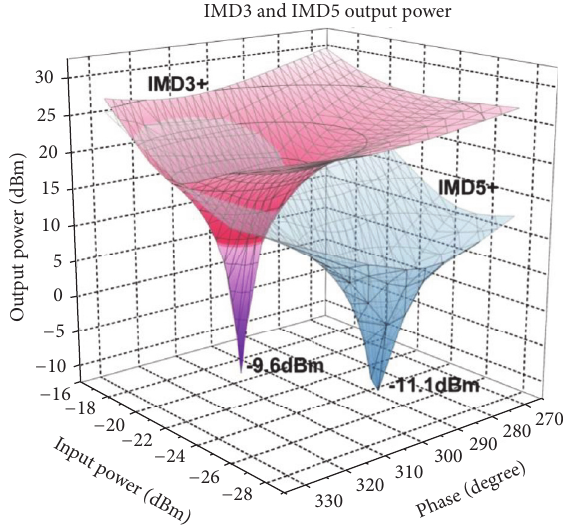
Figure 4: The 3D plot of the output power at IMD3 and IMD5 according to the phase and amplitude of injected IM3+